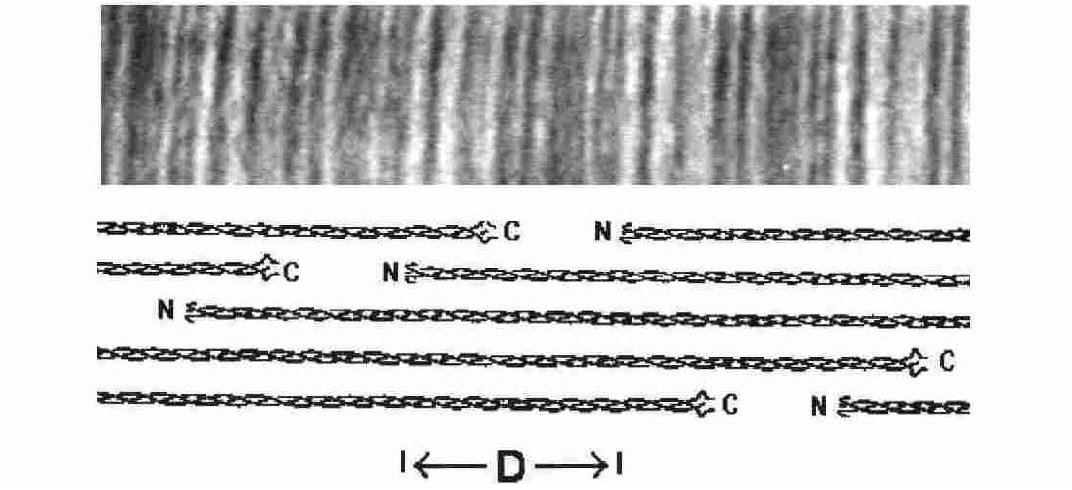
FIGURE 1. (Top) A positive staining pattern from arachnoid and dura mater rat collagen fibrils suitably aligned with the corresponding array of D-staggered molecules (bottom). The schematic representation of the axial relationships between molecules in a collagen fibril is based on “Hodge-Petruska” packing